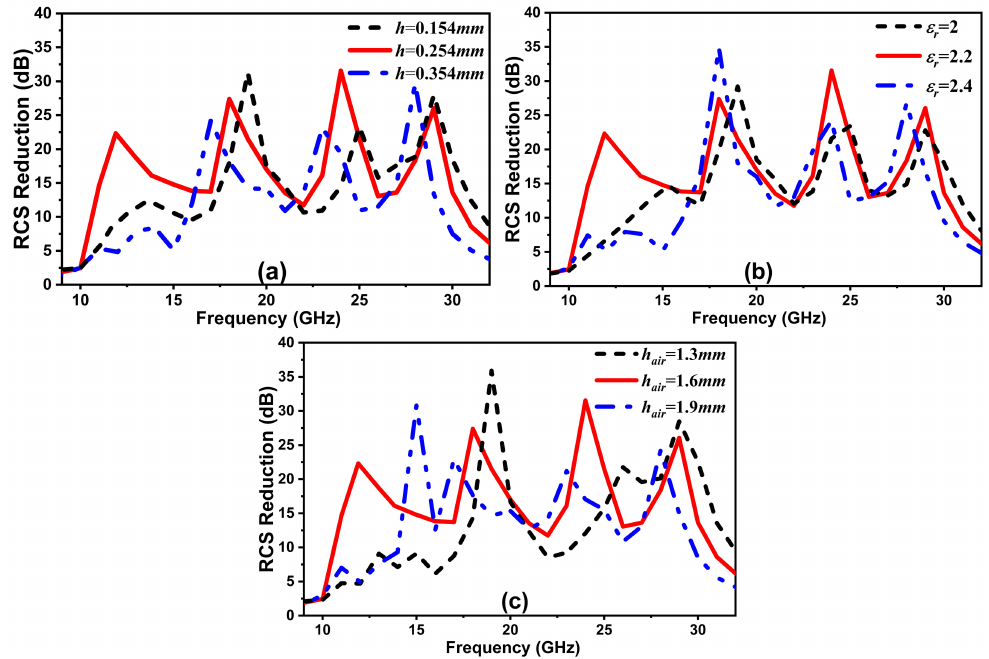
Figure 14. RCS reduction for different ( a ) h ( b ) (cid:101) r and ( c ) h air under normal x